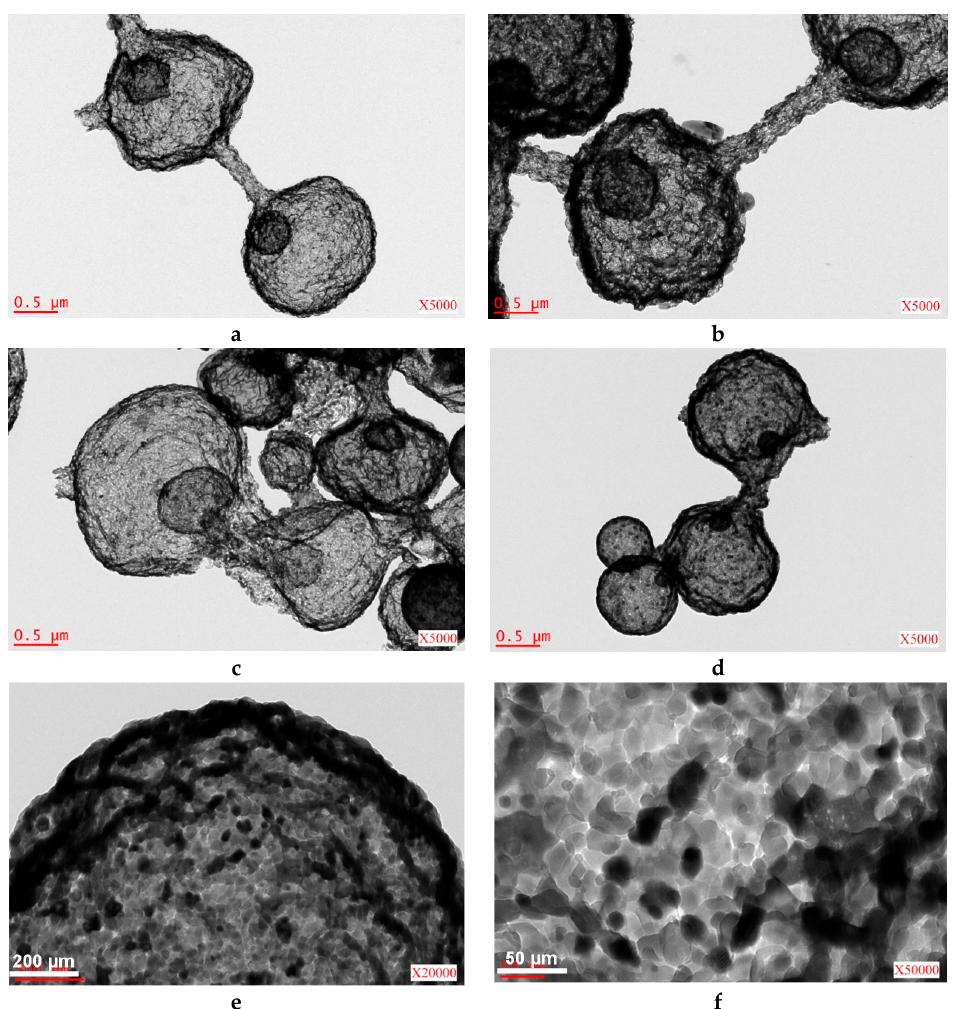
Figure 6. TEM pictures of hollow iron oxide microspheres: ( a – d ) general views at the same magnification; ( e – f ) same as ( d ) but at higher magnifications.